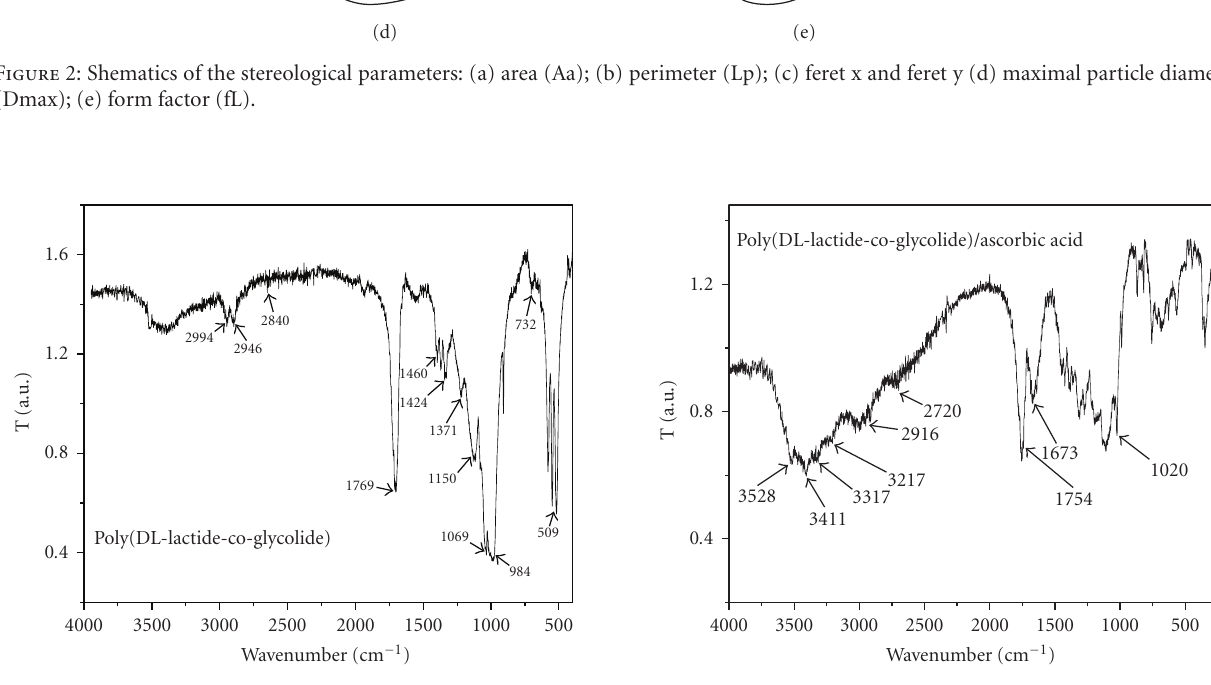
Figure 3: IR spectra of the DLPLG nanoparticles. Figure 4: IR spectra of the DLPLG/ascorbic acid 85/15% nanopar-